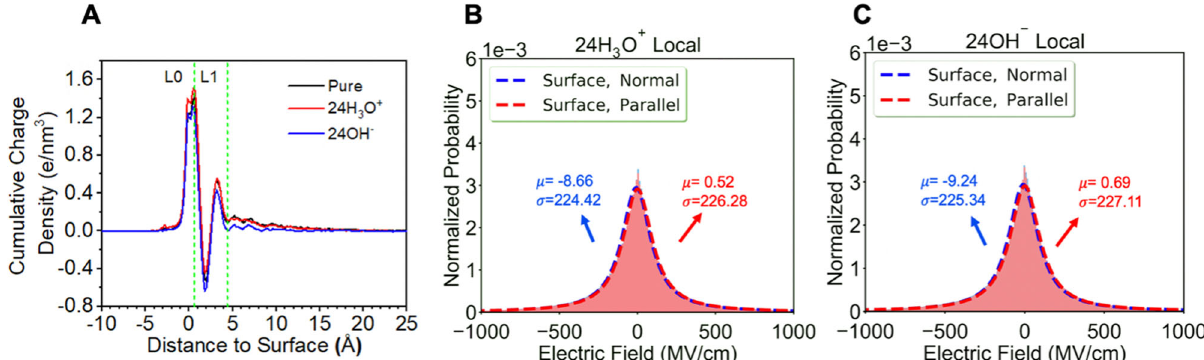
Fig. 3 Interfacial electric fi elds of droplets in the presence of excess hydronium and hydroxide ions . A Cumulative charge density for pure water and in presence of excess H 3 O + or OH − . The Lorentzian signatures of the electric fi elds normal to the surface for the R40 water droplet with ( B ) H 3 O + and ( C ) OH − corresponding to 88% of the Raleigh